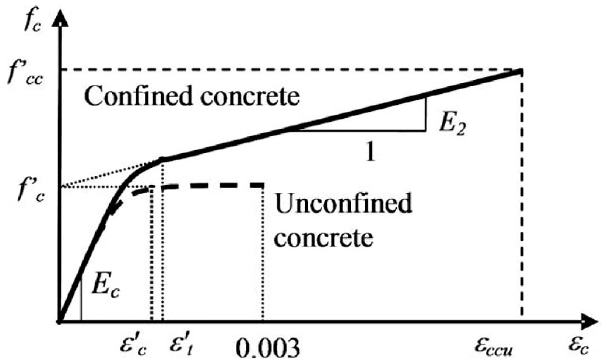
Figure 2. Stress ‐ strain curve of unconfined and FRP ‐ confined concrete based on Lam and Teng Figure 2. Stress-strain curve of unconfined and FRP-confined concrete based on Lam and model [23,24]. Teng model